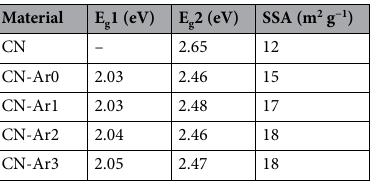
Table 1. Band gap energies and SSA of CN and CN-Ar materials.